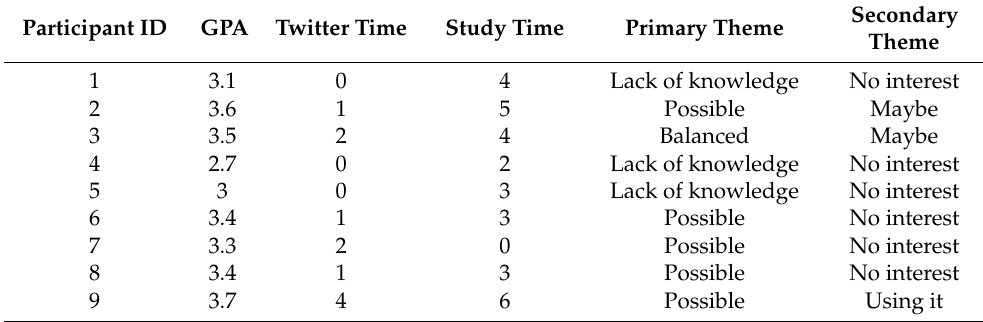
Table 5. Merging table (side-by-side